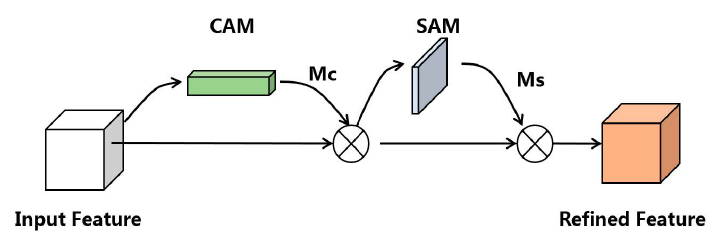
Figure 1. The architecture of the CBAM.